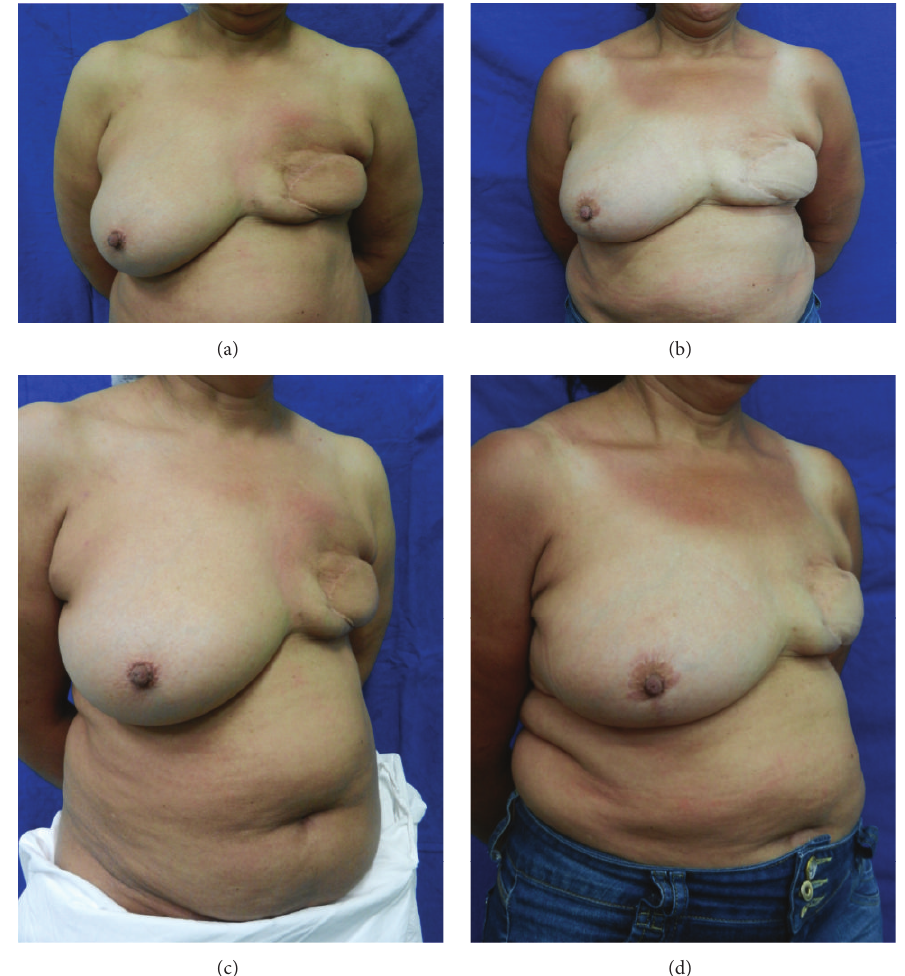
Figure 3: (a, c) Preoperative frontal and oblique views of a CG patient in which 147cc of fat was injected; (b, d) 12-month postoperative frontal and oblique views with volumetric persistency of